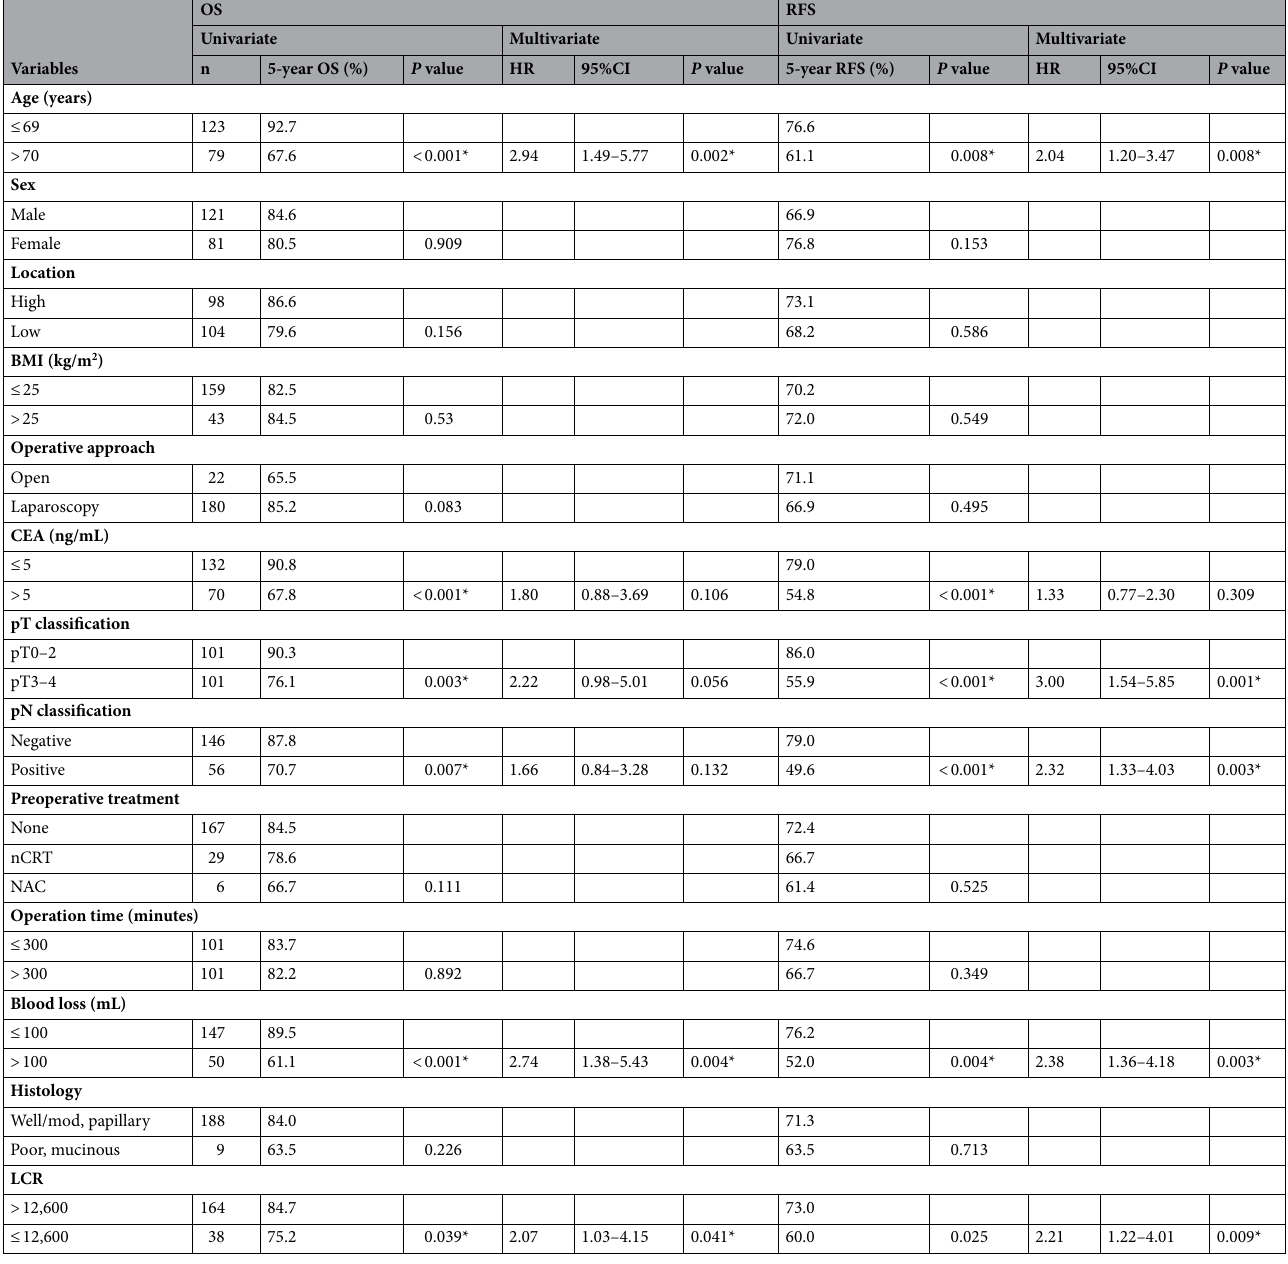
Table 5. Univariate and multivariate analyses showing impact of clinicopathological characteristics and LCR on OS and RFS. CI confidence interval, HR hazard ratio, OS overall survival, RFS recurrence-free survival, BMI body mass index, CEA carcinoembryonic antigen, pT pathological stage based on the tumor size and spread of cancer to nearby tissue, pN pathological stage based on spread of cancer to nearby lymph nodes, well/mod well- differentiated/moderately-differentiated, poor poorly-differentiated, LCR lymphocyte count/C-reactive protein ratio. *P <